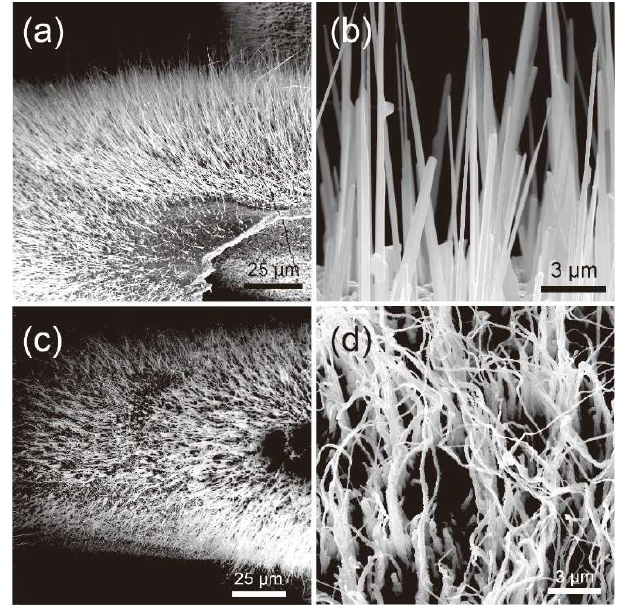
Figure 2. Low- and high-magnification SEM images of ( a , b ) as-synthesized CuO/Cu 2 O NWs and ( c , d ) thermally reduced Cu NWs.